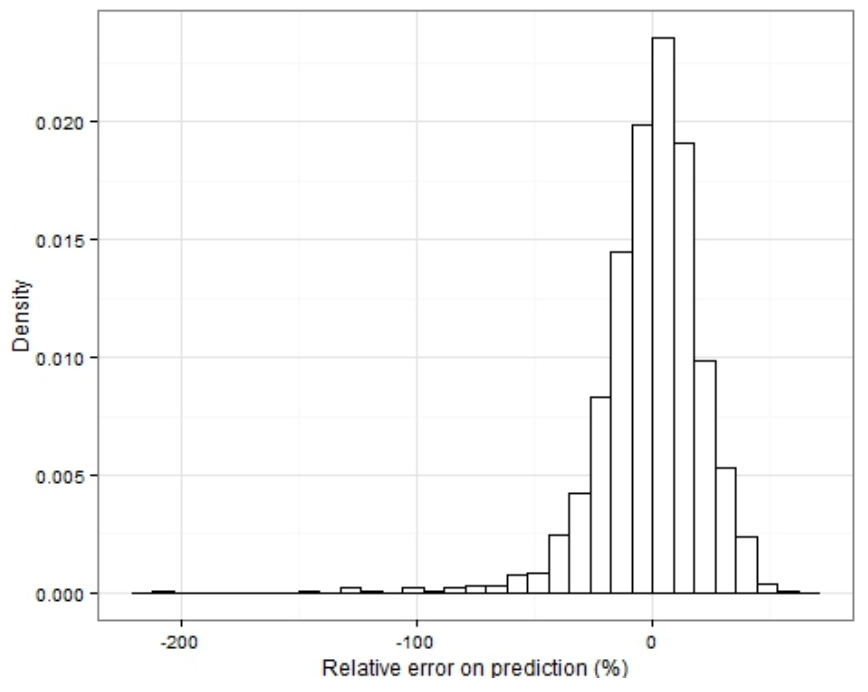
Figure 7. Distribution of the relative errors (%) for the macro